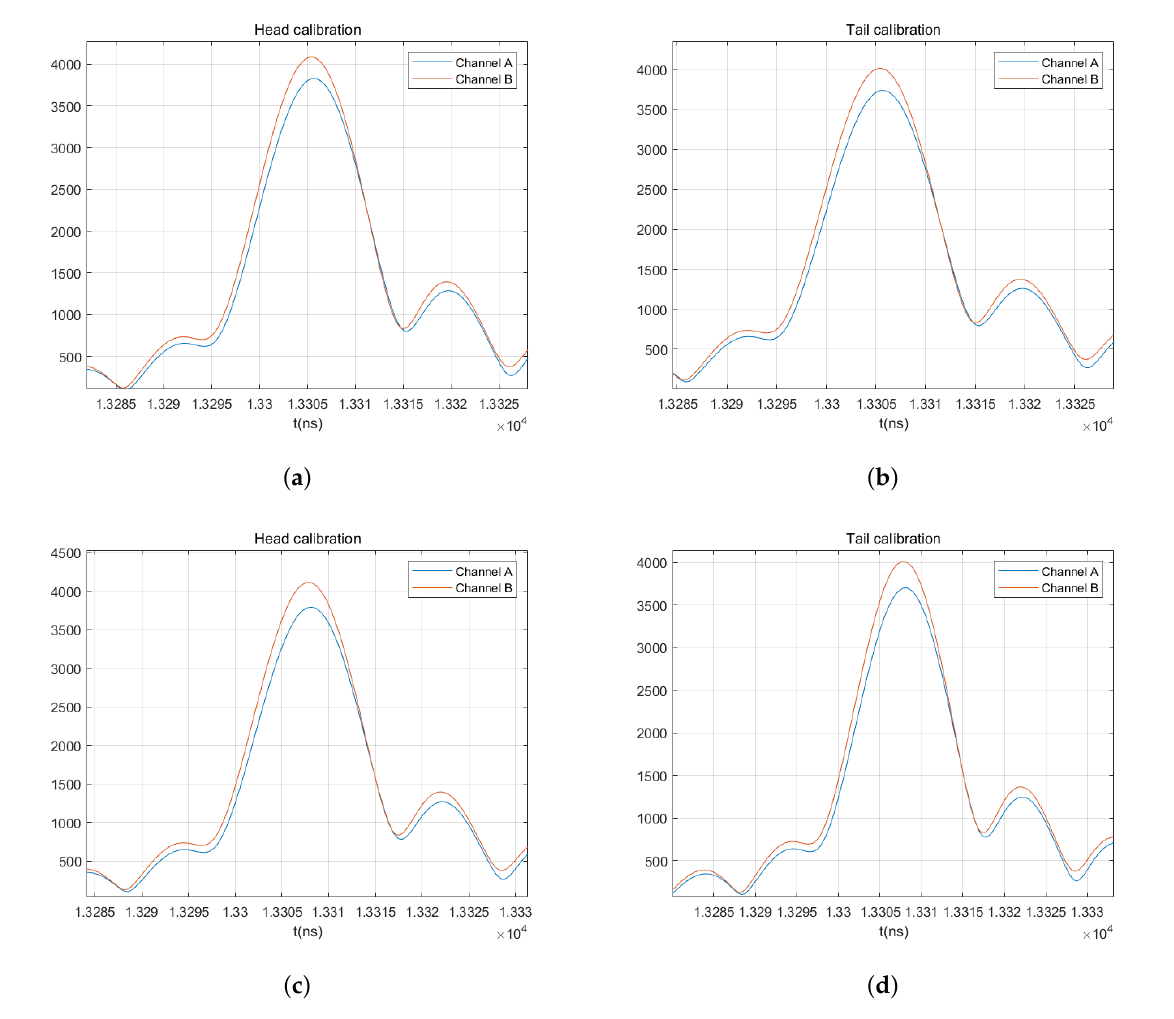
Figure 8. After the dual-channel signal pulse compression of the internal calibration data, the peak position is partially enlarged. ( a ) The head calibration result of the first set of data; ( b ) the tail calibration result of the first set of data; ( c ) the head calibration result of the second of set data; ( d ) the tail calibration result of the second of set data. Table 4. The position offset of dual-channel images in range caused by each